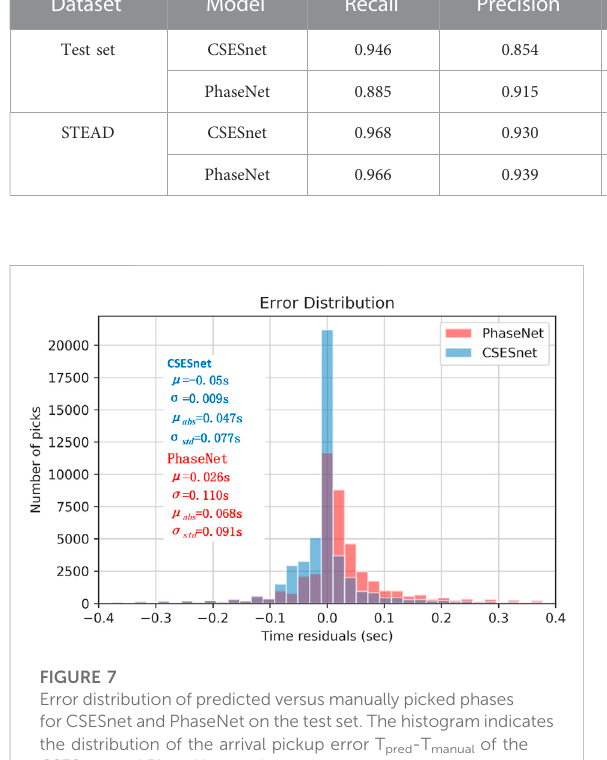
FIGURE 7 Error distribution of predicted versus manually picked phases for CSESnet and PhaseNet on the test set. The histogram indicates the distribution of the arrival pickup error T pred -T manual of the CSESnet and PhaseNet on the test set.